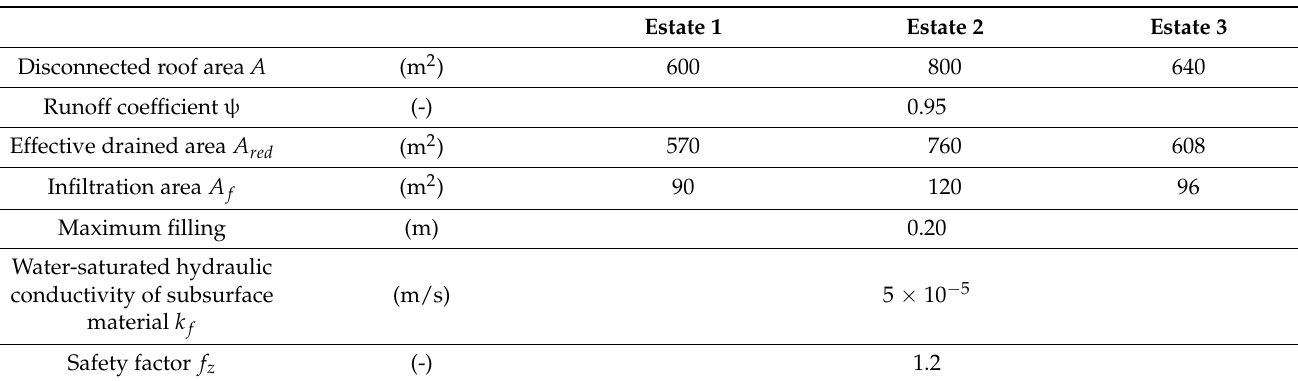
Table 15. Input data adopted for bioswale sizing.